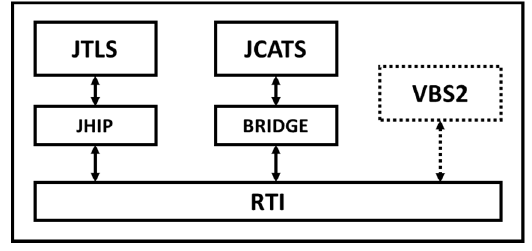
Figure 18. NATO training federation (Adapted from [48]).